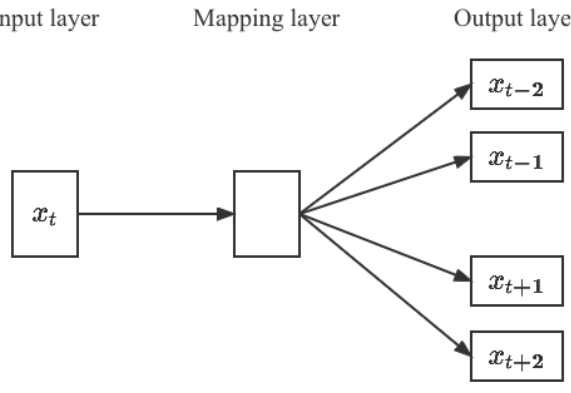
Figure 1. Skip-gram model